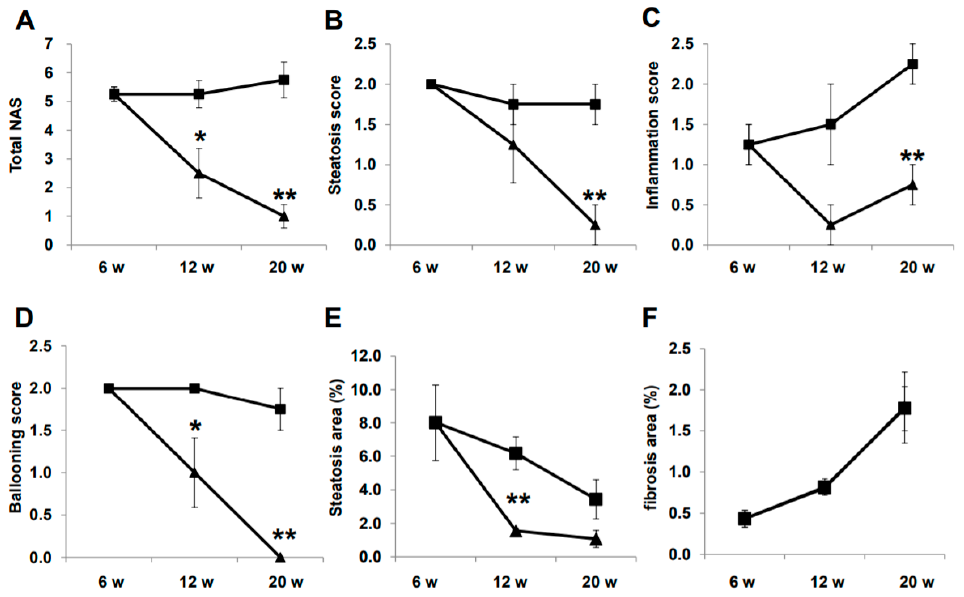
Figure 4. Histological evaluation of non-tumorous lesions. Mice were euthanatized at 6 ( n = 4 for baseline), 12 ( n = 6/group), and 20 ( n = 6/group) weeks (w) of age. Changes in total nonalcoholic fatty liver disease activity score (NAS) ( A ), steatosis score ( B ), inflammation score ( C ), ballooning score ( D ), fat deposition areas evaluated using oil red O-stained samples ( E ), and fibrotic areas evaluated using Sirius red-stained samples ( F ) are presented as line graphs. Data are presented as the mean, and error bars represent the standard deviation. Triangle: liraglutide-treated mice (LIRA); square: control mice (CTR). * p < 0.05 and ** p < 0.01 vs. CTR.